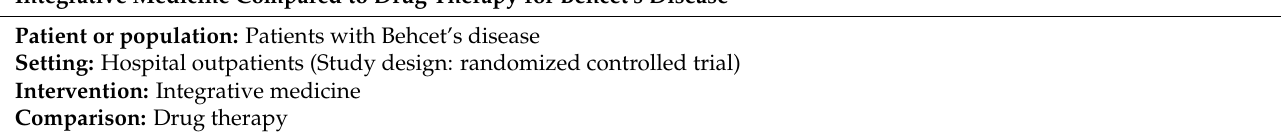
Table 3. Summary of